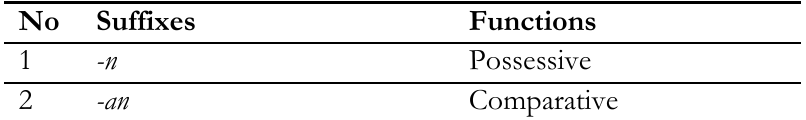
TABLE 2. Suffix ’s